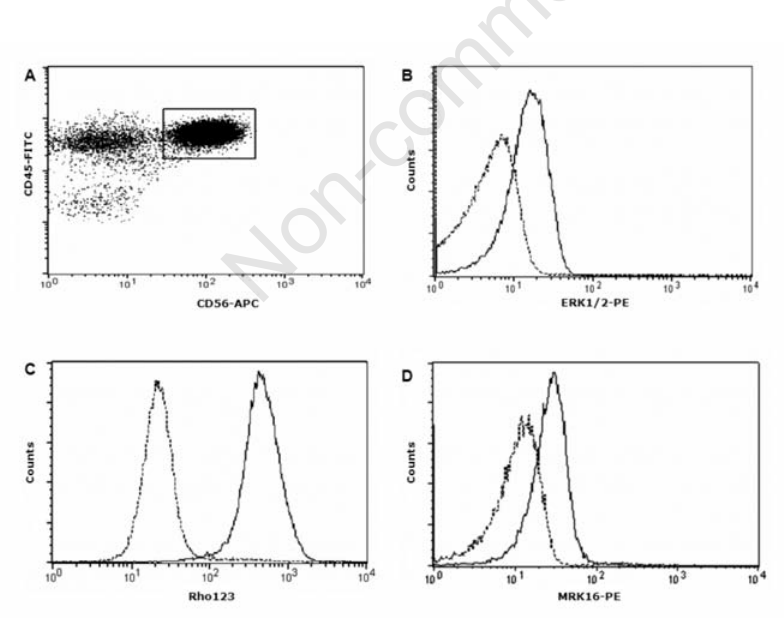
Figure 2. Analysis of NK-leukaemic cells. A) Gating of bone marrow CD56+ leukaemic cells for phenotypic and functional analysis; B) Antibody staining of phosphorylated ERK1/2 (solid line) in relation to isotypic control (dashed line); C) P-gp activity assessed by Rhodamine 123 efflux test: Rho123 efflux (dashed line) in relation to Rho123+ inhibitor (verapamil) (solid line); and D) P-gp expression by Mrk16 antibody staining (solid line) in relation to isotypic control (dashed line). Explanation in the